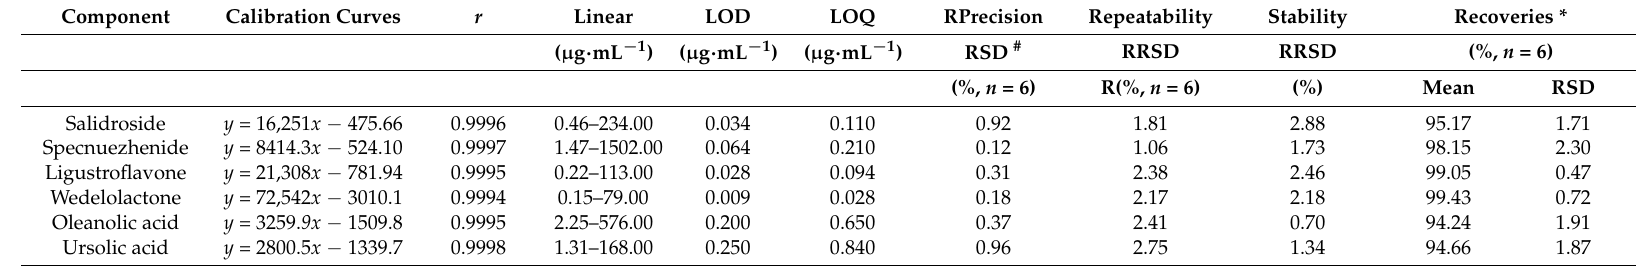
Table 1. Calibration curves, limits of detection (LODs), limits of quantitation (LOQs), precision, repeatability, stability, and recoveries of the six analytes.